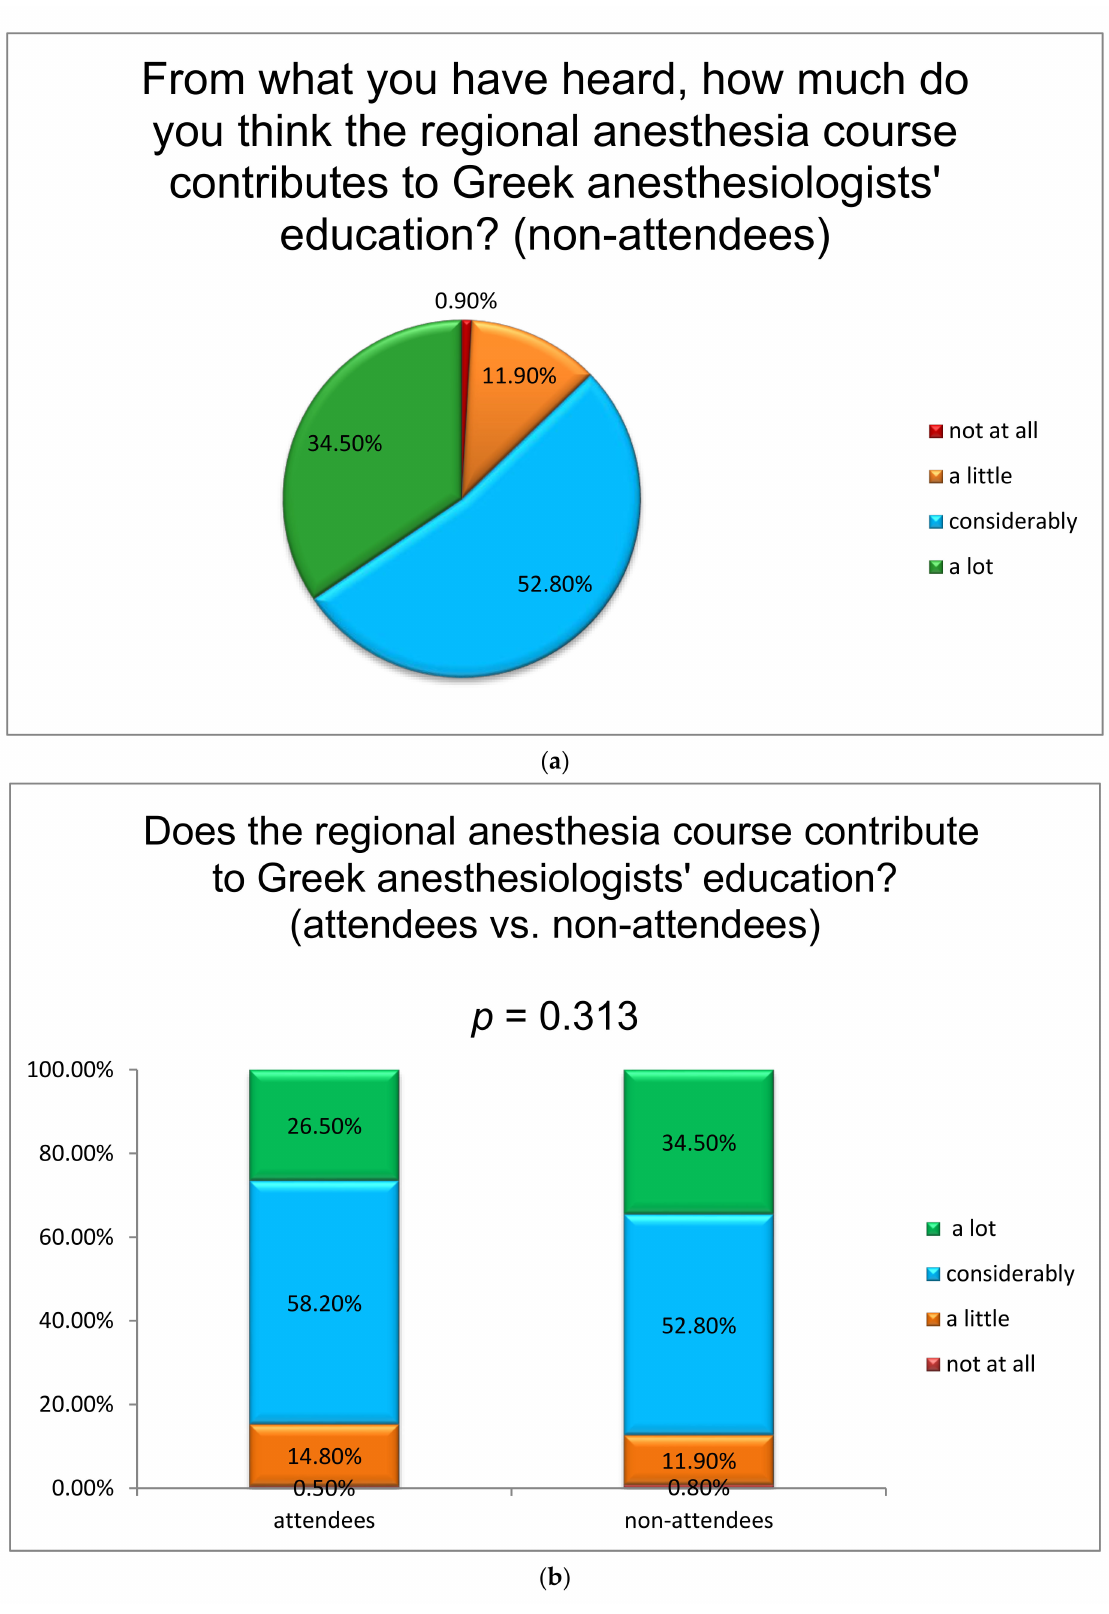
Figure 3. ( a ) Contribution of the course to regional anesthesia education of Greek anesthesiologists according to people who have not attended the regional anesthesia course; ( b ) Contribution of the course to regional anesthesia education of Greek anesthesiologists (attendants versus non-attendants of the regional anesthesia